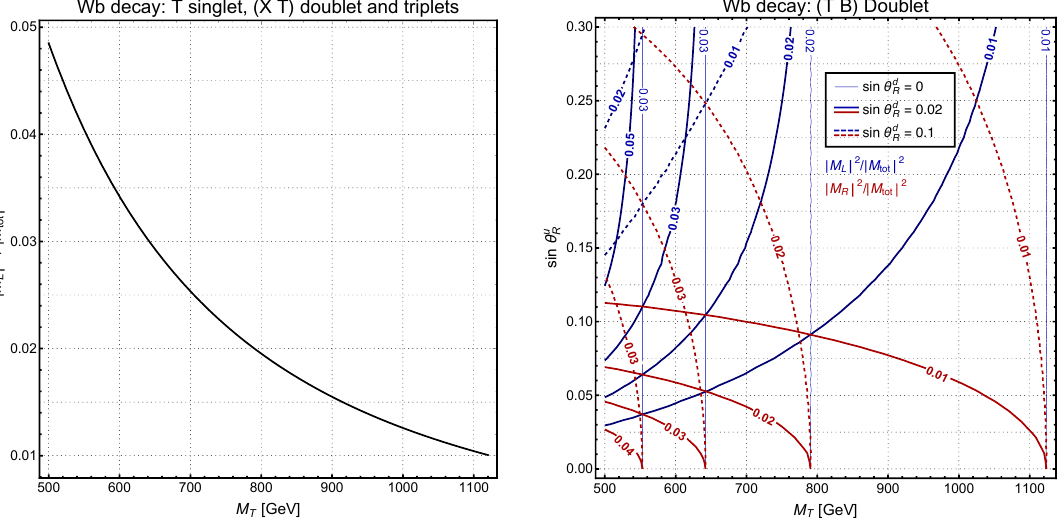
Figure 1 . Fraction of left-handed and right-handed polarised W boson arising from the charged current decay of a T VLQ. In the left panel the singlet, ( X T ) doublet and triplet representations are shown as function of m T , while in the right panel the ( T B ) doublet representation is shown in the m T (cid:0) sin (cid:18) u plane for di(cid:11)erent values of sin (cid:18) d . R R